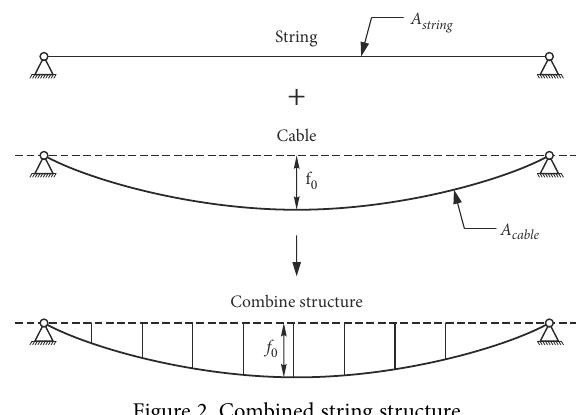
Figure 2. Combined string structure Table 4. Dependence of cross-sectional areas of